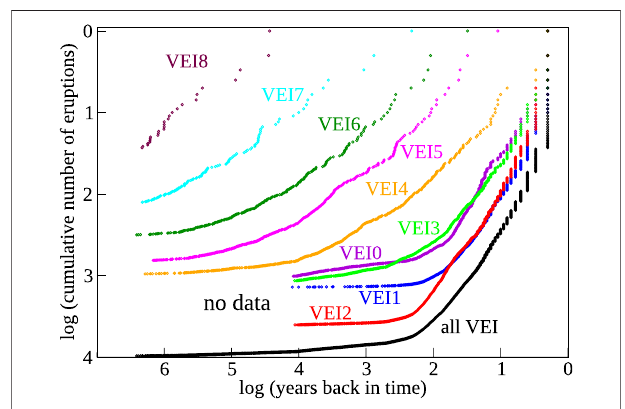
FIGURE 1 | Observed cumulative number of eruptions vs. time, for all eruptions (black) and for different VEI classes (colors). VEI 0 – 3 eruptions are reported in the Smithsonian GVP database which refers to only the Holocene. Thetimeresolutionforthisplotis1 year,andtime0istakenatyear2022 CE. Slope decrease when moving back in time, larger for lower VEI eruptions, re fl ects loss of preservation in the geological record with increasing eruption age. Complex distributions are visible for the large VEI eruptions, where periods with largely variable rate alternating to variably long periods of stasis emerge. Those distributions are entirely similar to the ones from lower VEI eruptions (or from all eruptions together), although less or not visible at the scale and resolution of this